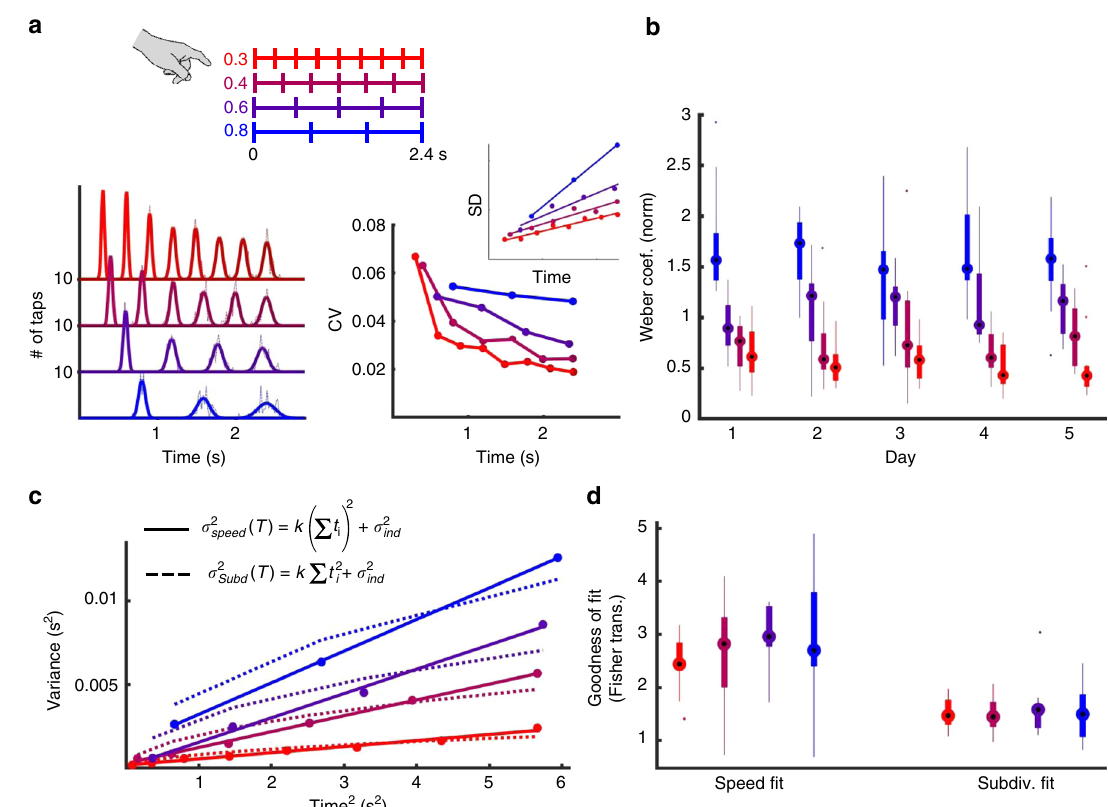
Fig. 6 Comparison of the Weber-Speed and subdivision hypotheses using a periodic task. Subjects were trained on four periodic auditory temporal patterns all lasting 2.4 s (periods of 0.3, 0.4, 0.6, and 0.8 s) over 5 days. a Left: Histogram (dashed lines) and Gaussian fi ts (solid lines) of the taps at all four speeds for a single subject. Right: CV of each tap at each speed, with SD vs. mean time shown as the inset. b Whisker plots of the Weber coef fi cient of all subjects ( n = 11) across the 5 days of training. c Example fi ts of the variance at time T composed of n subintervals ( t 1 , t 2, … , t n ) according to the speed (continuous, solid lines) and subdivision (reset, dashed lines) hypotheses ( σ 2 represents the time independent source of variance). d Goodness of fi t values (Fisher- ind transformed r 2 ) for both the speed and subdivision hypotheses for each speed across all subjects (data shown are from the last day of